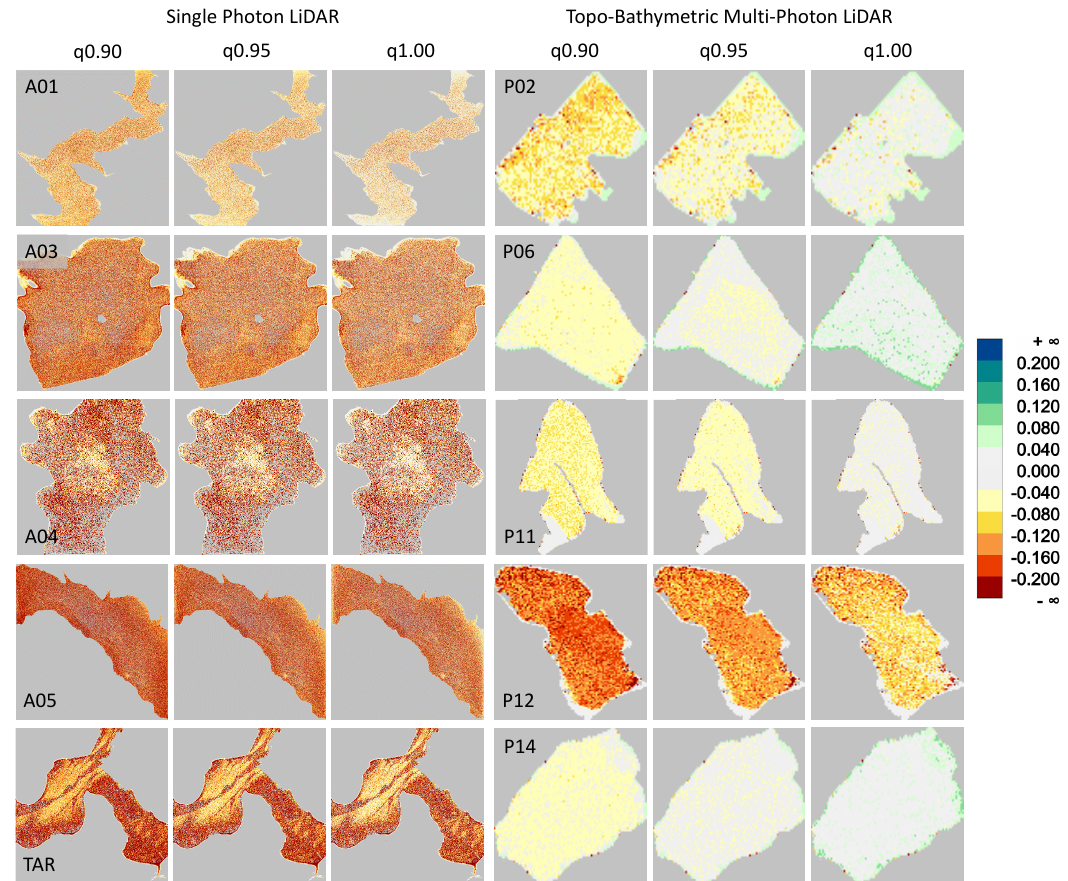
Figure 9. Deviations between reference water level and 2m digital water surface model grids calculated for selected Single- and Multi-Photon LiDAR water bodies and height quantiles.